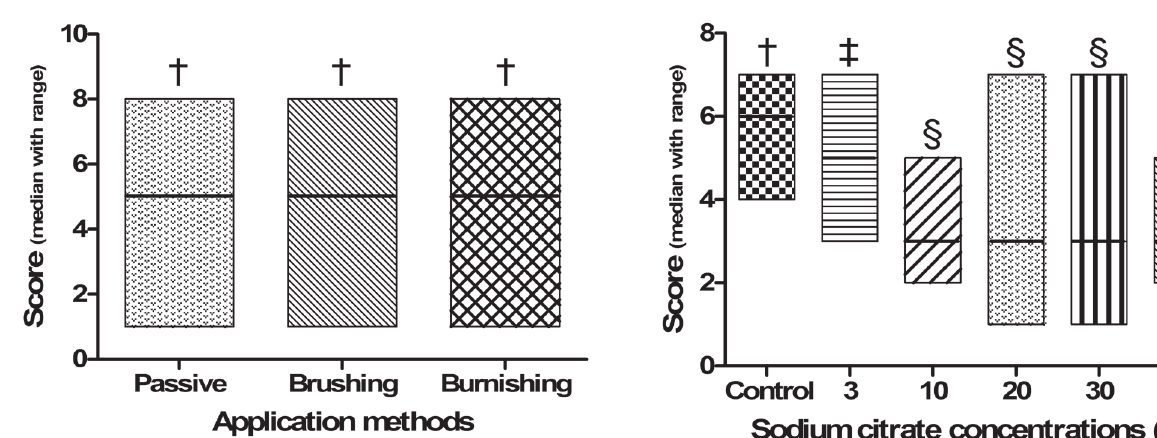
Figure 5- Median with range of the scores obtained for the five concentrations of sodium citrate and the control group. Concentrations with the same symbol are not